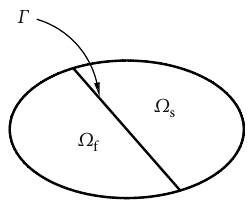
Figure 2: Fluid-solid interaction.